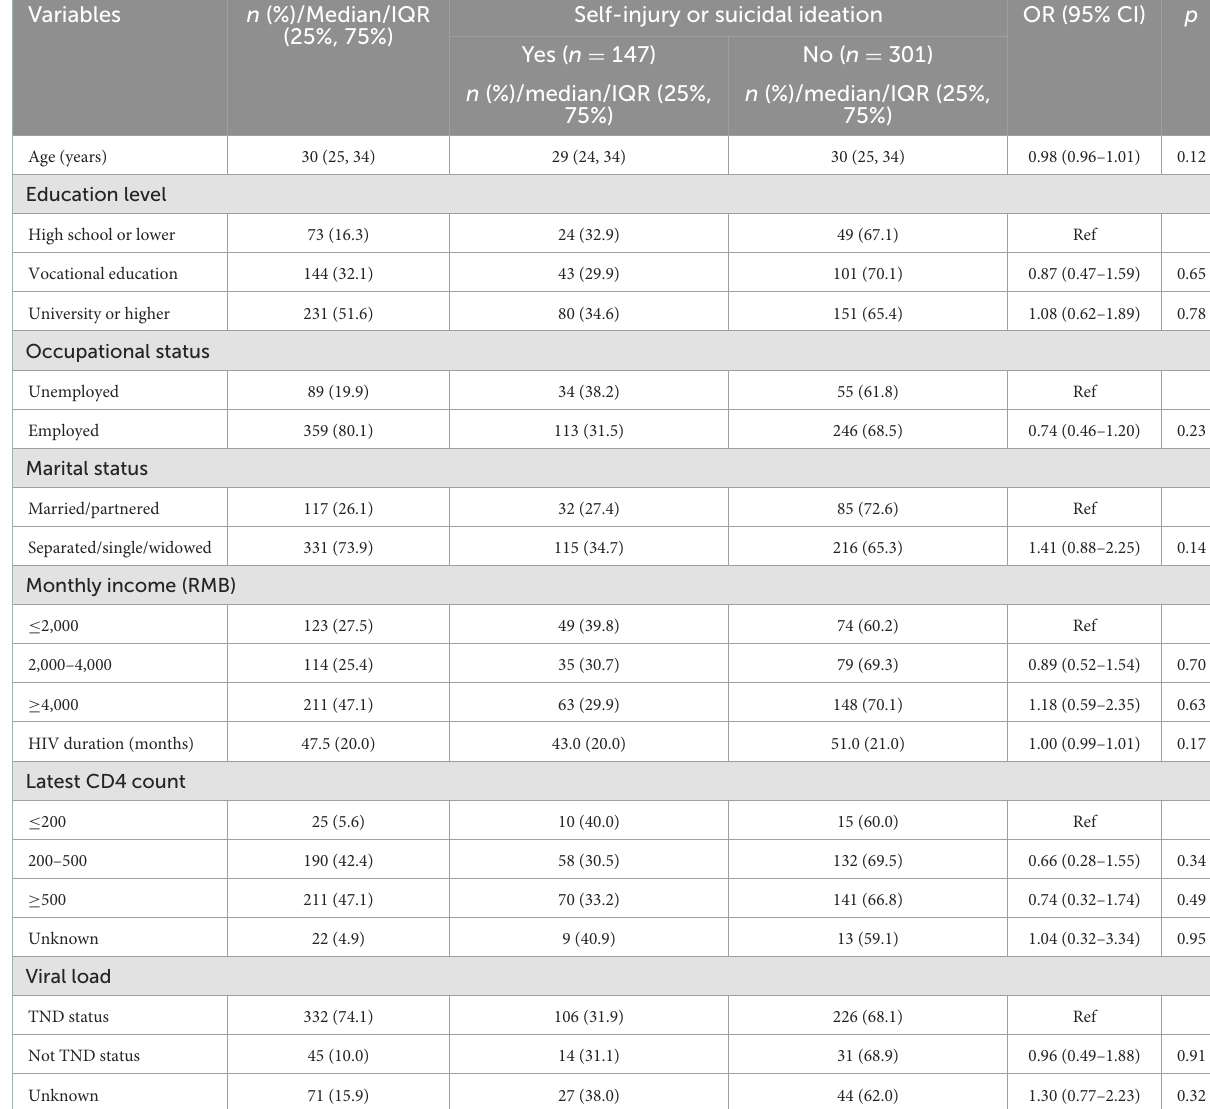
TABLE 1 Differences in self-injury or suicidal ideation according to general characteristics ( n =